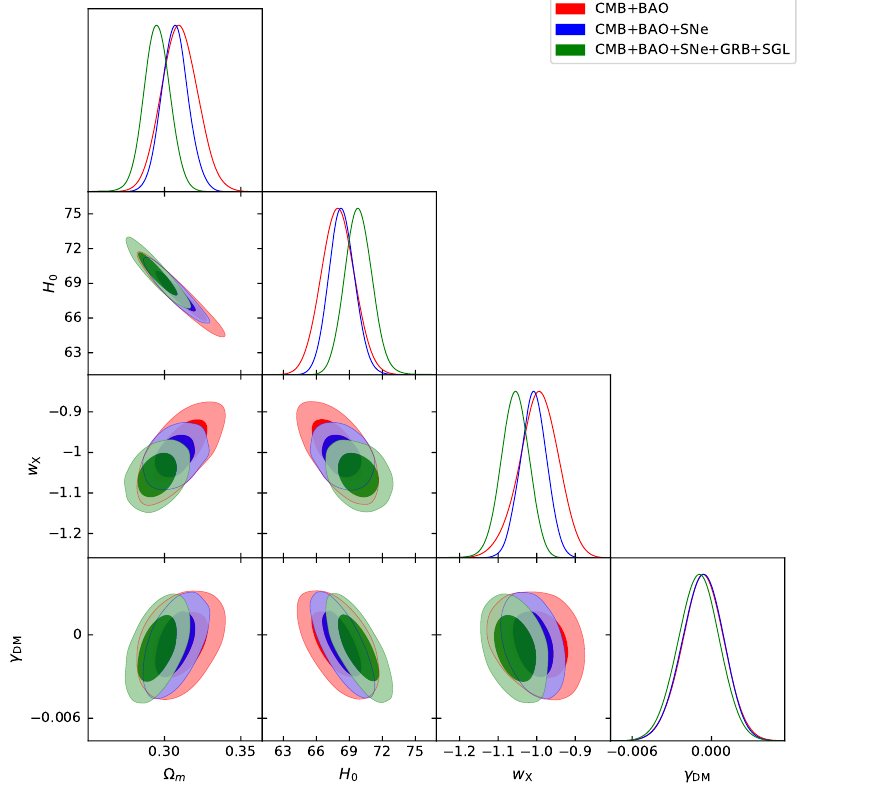
Figure 2 . The 2D contour line are obtained by using (CMB+BAO), (CMB+BAO+SNe) and